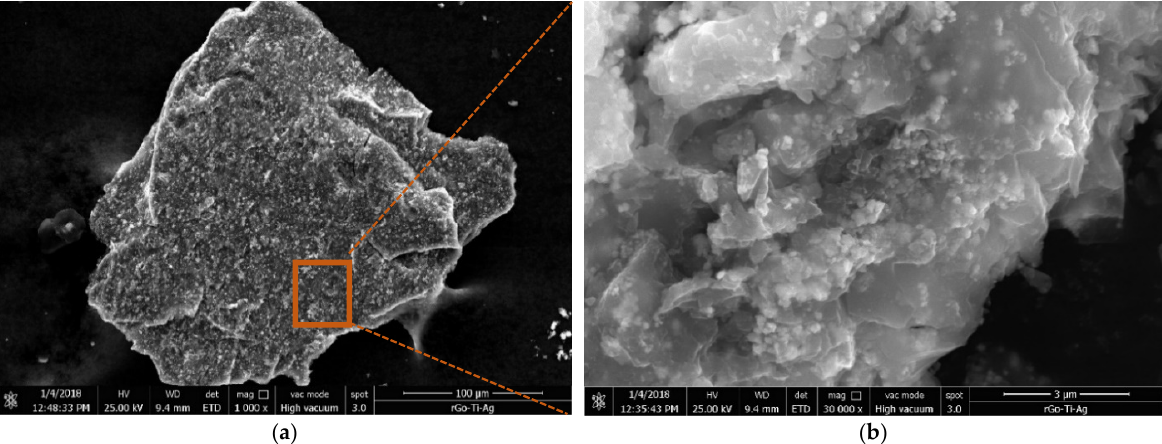
Figure 2. SEM images of rGO-TiO 2 -Ag: SEM magnification of ( a ) 1000× and ( b ) 30,000×.